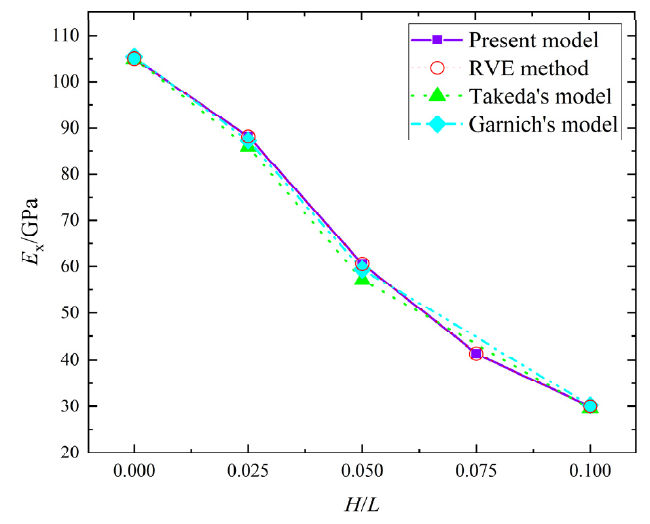
Figure 5. E x in the four models. Figure 5. 𝐸 (cid:2934) in the four models Figure 5. 𝐸 (cid:2934) in the four models